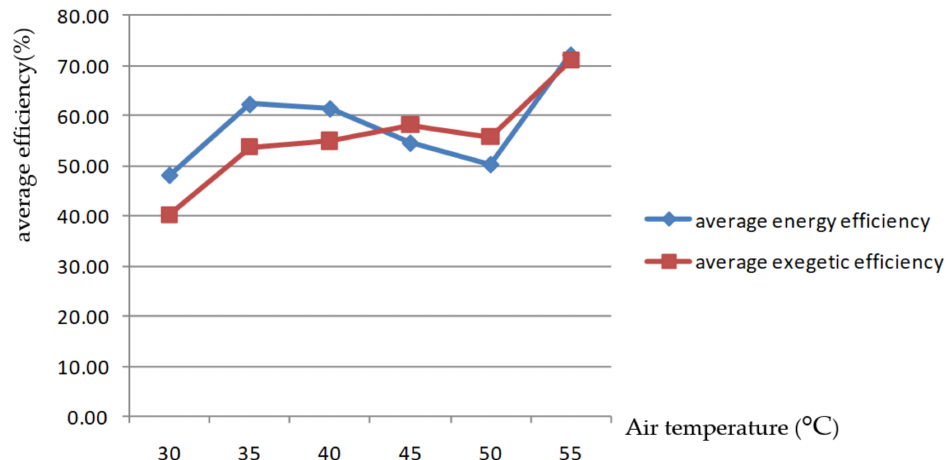
Figure 6. Changes in average energy efficiency and exergy efficiency of the drying process with temperature of drying